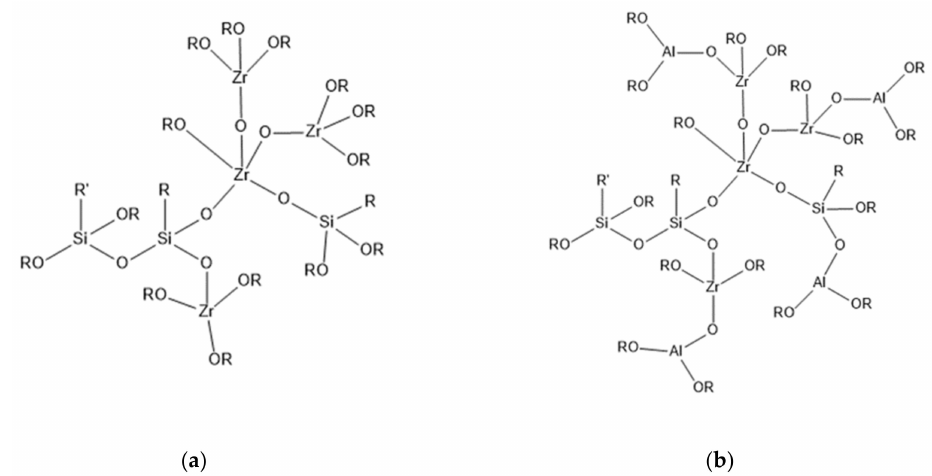
Figure 16. The cross-linked network structure of the molecular skeleton, ( a ) –O–Zr–O–Si–O–; ( b )